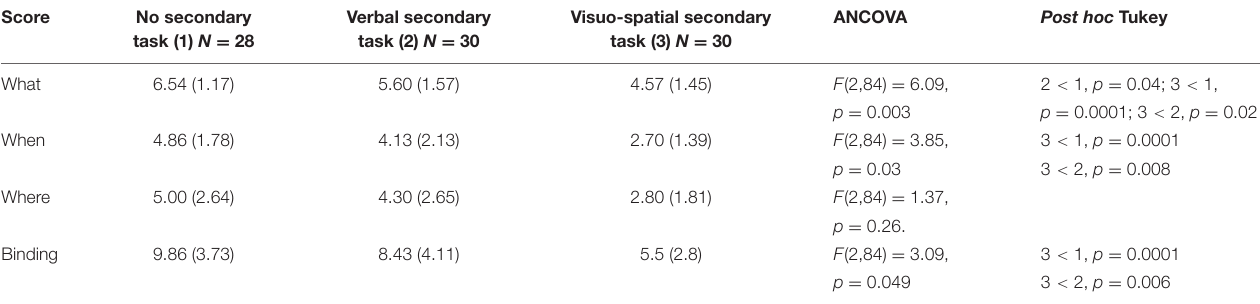
TABLE 1 | Means and standard deviations of episodic scores for the various experimental conditions and results of ANCOVAs and post hoc Tukey tests. 1